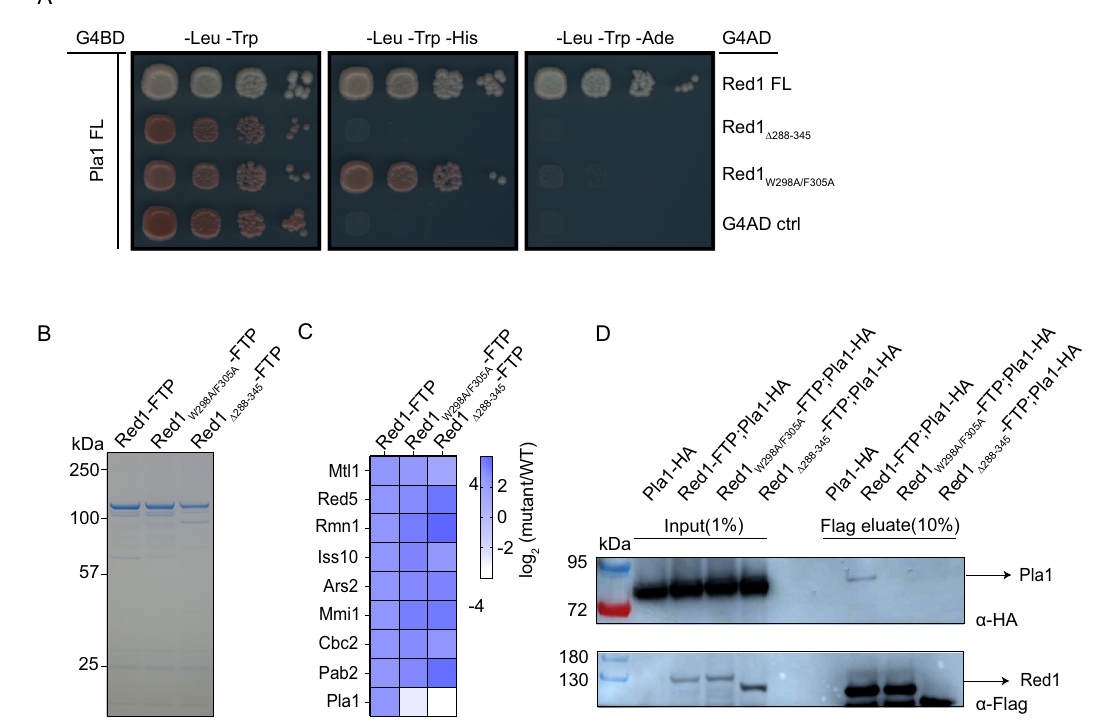
Fig.4|DisruptingRed1-Pla1interactioninvivoleadsto ‘ Pla1-truncated ’ MTREC complex.A Y2HexperimentsshowingtheeffectsofdeletionofRed1residues288- 345orRed1 W298A/F305A doublemutantonPla1-Red1interactioninthecontextoffull- length proteins. B Coomassie blue stained SDS polyacrylamide gel of tandem af fi nitypuri fi edMTRECcomplexusingRed1asbait,fromrespectivemutantstrains (arepresentativegelfromtwoindependentexperimentsisshown);and C heatmap representationofmass-spectrometry(MS)analysisofthesepuri fi cations.Heatmap shows the changes in the amount of co-purifying MTREC subunits (except the Cbc1 subunit which was not conclusively quanti fi ed), in indicated mutant strains compared to WT. Co-purifying protein amounts were normalised to the corre- sponding puri fi ed bait protein (WT or mutant Red1) amount. D Co-